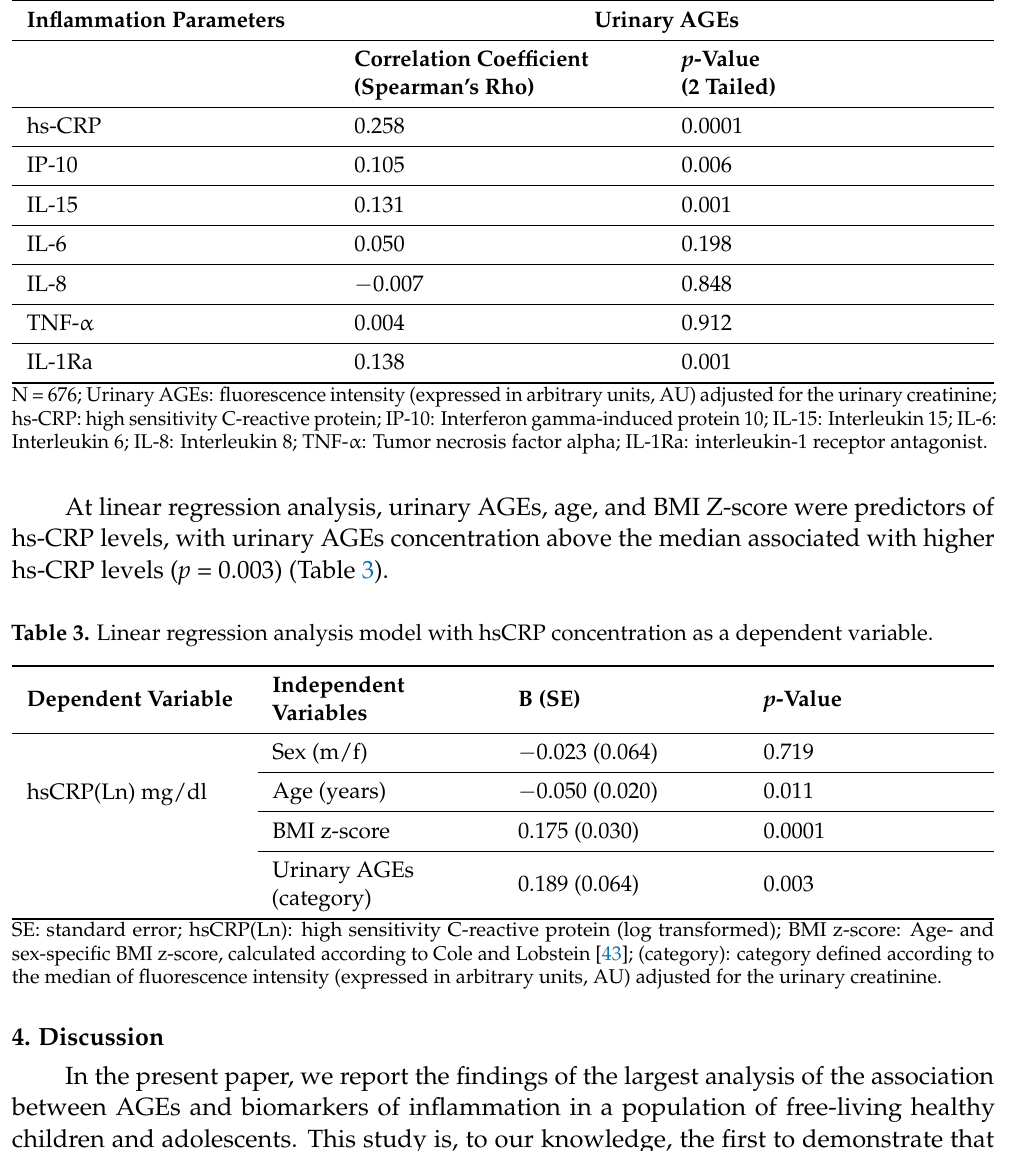
Table 2. Correlations between the urinary advanced glycation end products (AGE)-specific fluores- cence intensity and the investigated inflammation parameters.